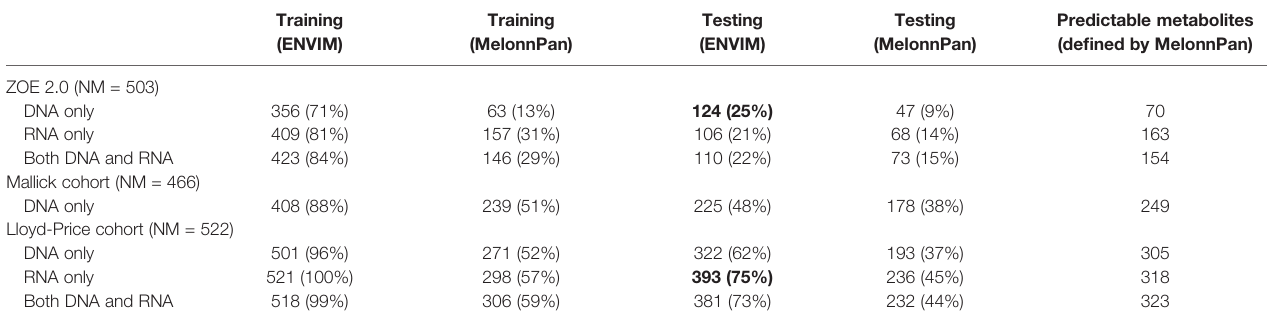
TABLE 2 | Prediction results ( fi rst four columns of numbers) in terms of Spearman correlation for all metabolites to be predicted. Training